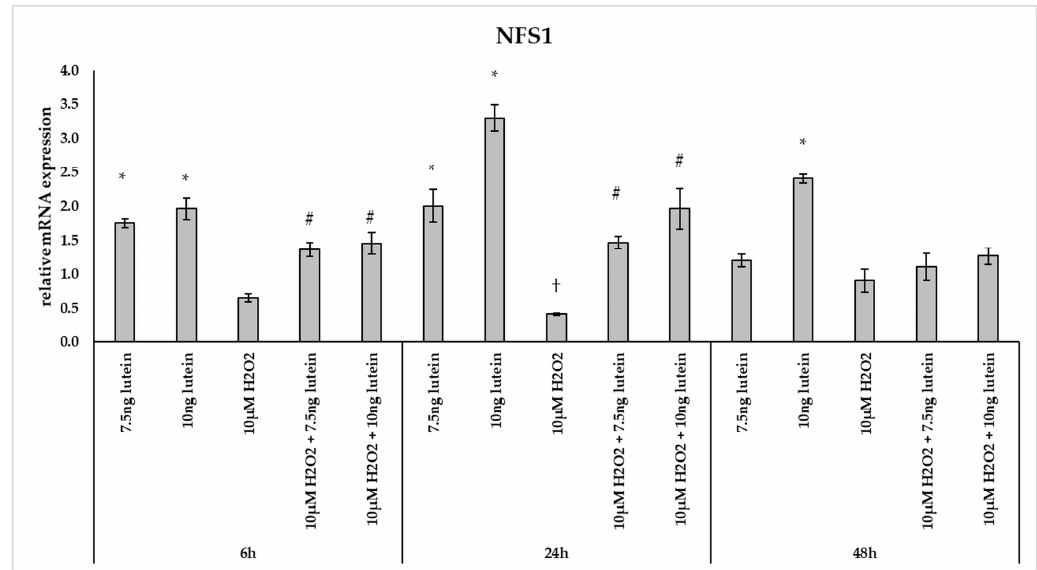
Figure 9. Effects of lutein and H 2 O 2 on NFS1 mRNA expression. The columns represent the mean values, and error bars indicate the standard deviation (SD) of three independent experiments ( n = 3), each performed in triplicate, and are presented relative to own control cells. * marks statistical significance of lutein treatments versus controls; † indicates statistical significance of H 2 O 2 -treated cells compared to controls; # represents statistical significance of combined (lutein with H 2 O 2 ) treatments compared to H 2 O 2 treatments; the level of significance was p < 0.05. Real-time PCR was performed with the SYBR green protocol using gene-specific primers. β -actin was used as house-keeping gene for the normalization. The relative expression of controls was regarded as